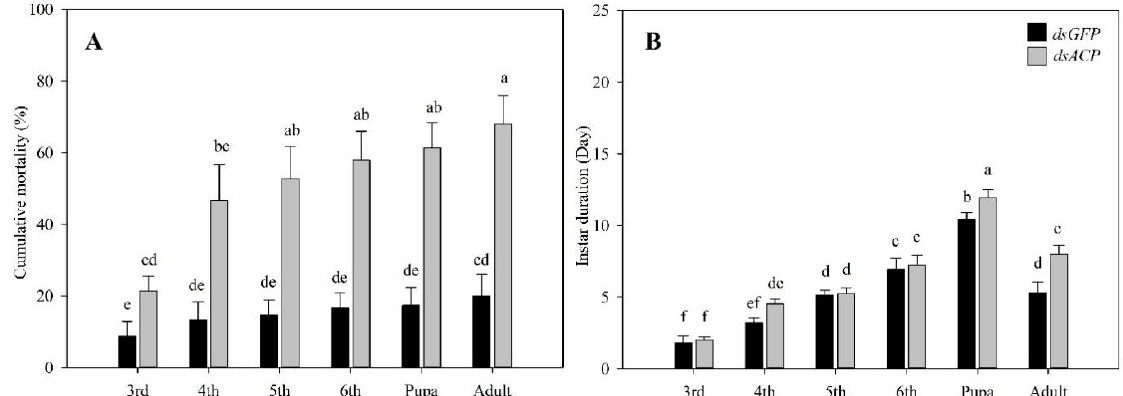
Figure 6. Cumulative mortality and instar duration of one-day-old 3rd instar larvae of H. illucen after dsACP (2000 µ g · mL − 1 ) injection of 1.5 µ L. ( A ): Cumulative mortality in different instars of 3rd instar larvae injected with dsACP . Y-axis values are the means of cumulative mortality in the different instars. ( B ): The duration of 3rd, 4th, 5th, 6th instar larvae, pupae, and adults. Y-axis values are the means of duration at different instars. Mean ± SE was calculated from three biological replicates, and each biological replicate contained 50 one-day-old 3rd instar larvae grown to different instars. Bars marked with different letters indicate significant differences between treatment and control (Student’s t -test, p < 0.05).